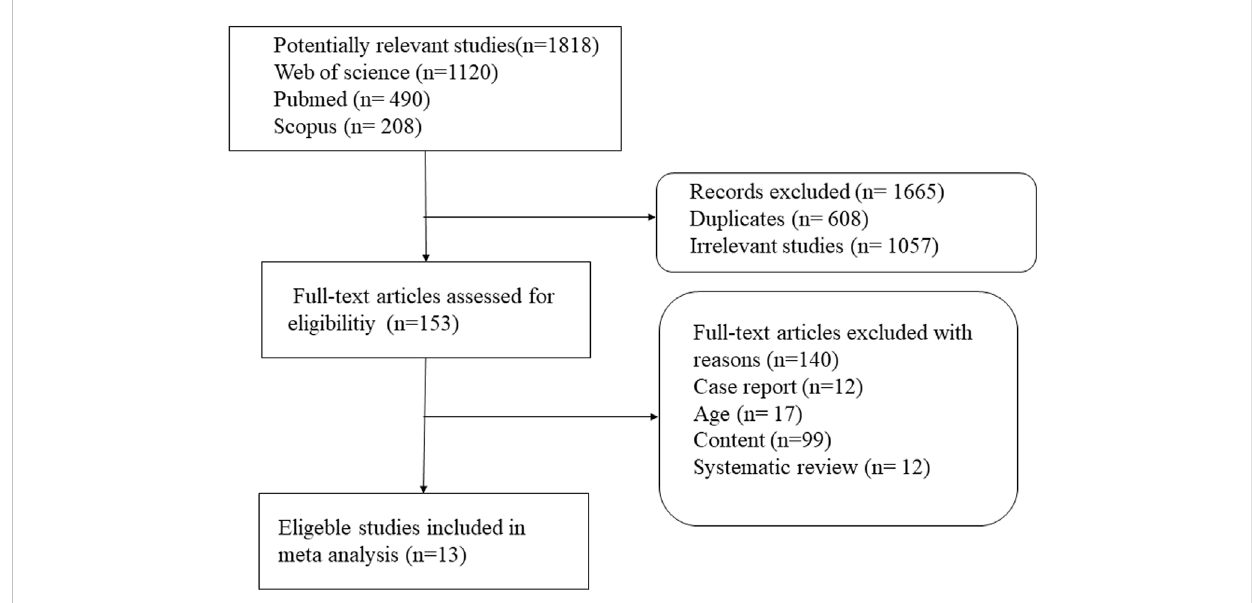
FIGURE 1 Procedure for search and selection of studies included in the systematic review and